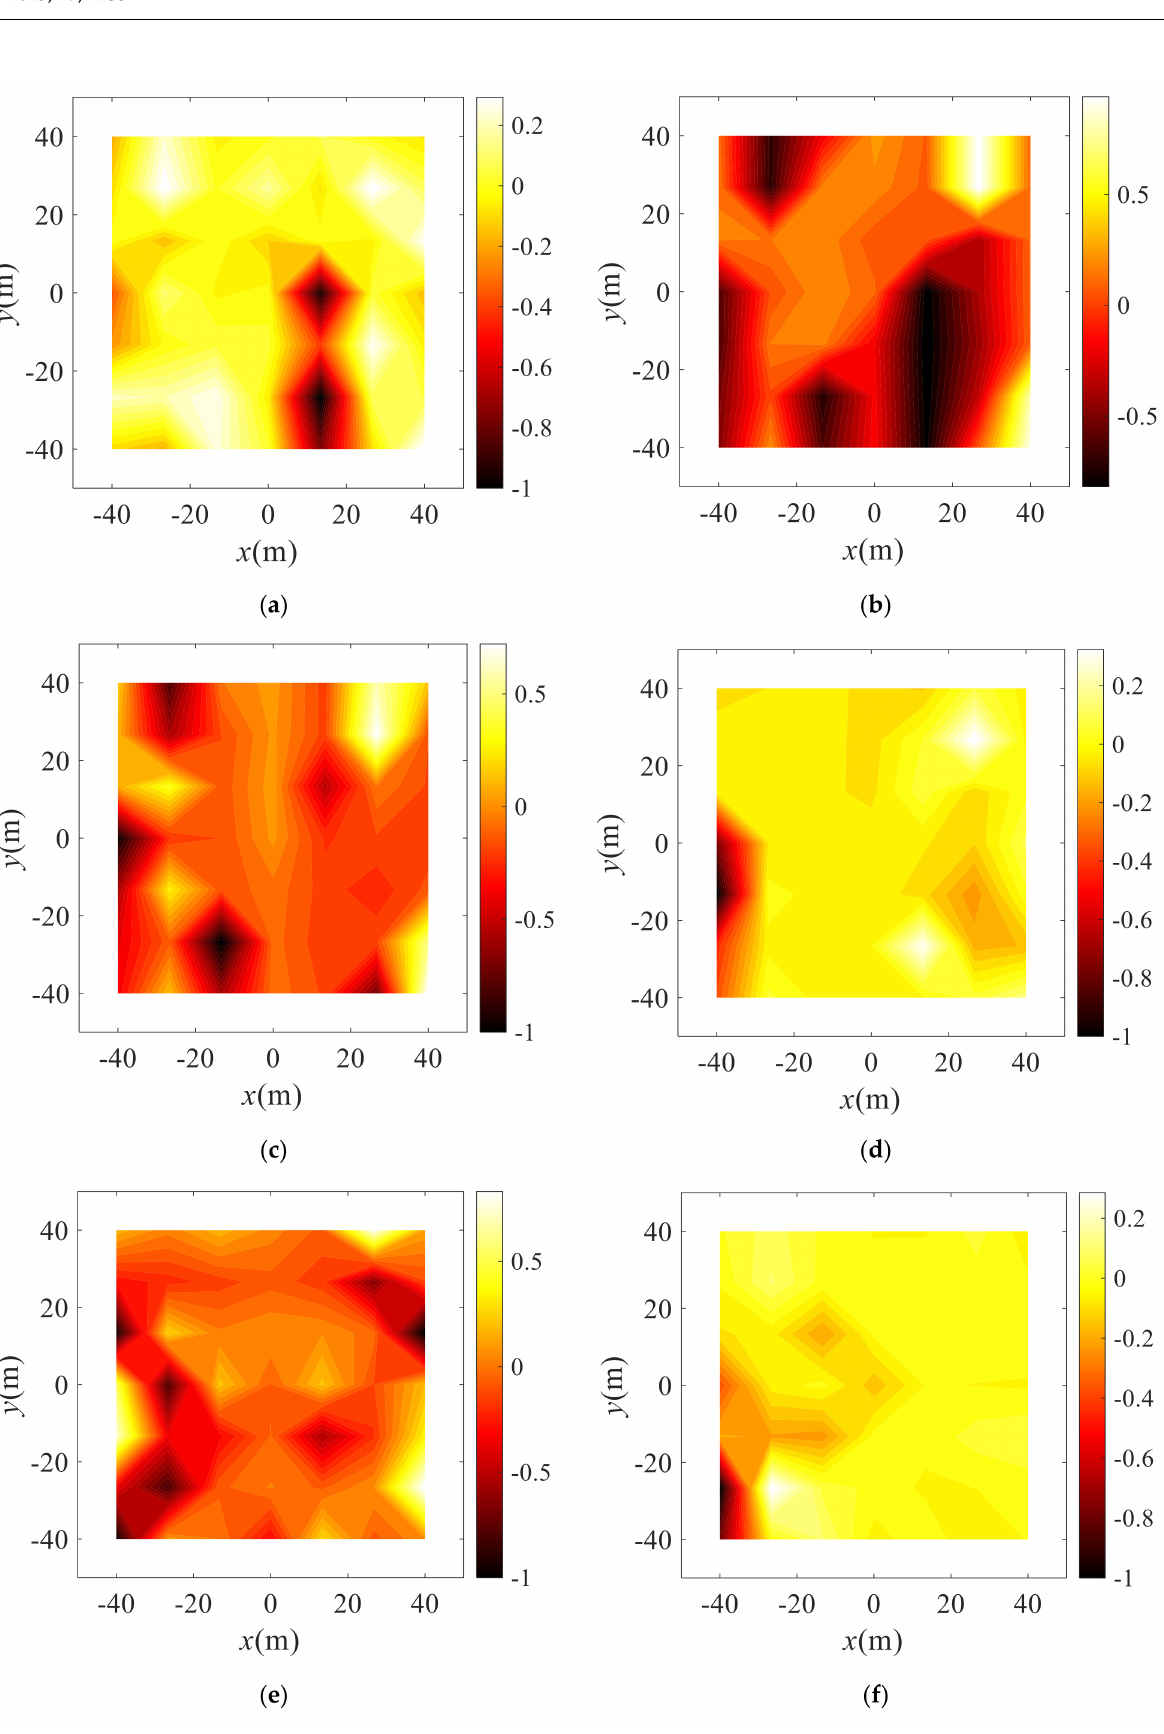
Figure 6. Structural modes by FFD: #1 ( a ), #2 ( b ), #3 ( c ), #4 ( d ), #5 ( e ) and #6 ( f